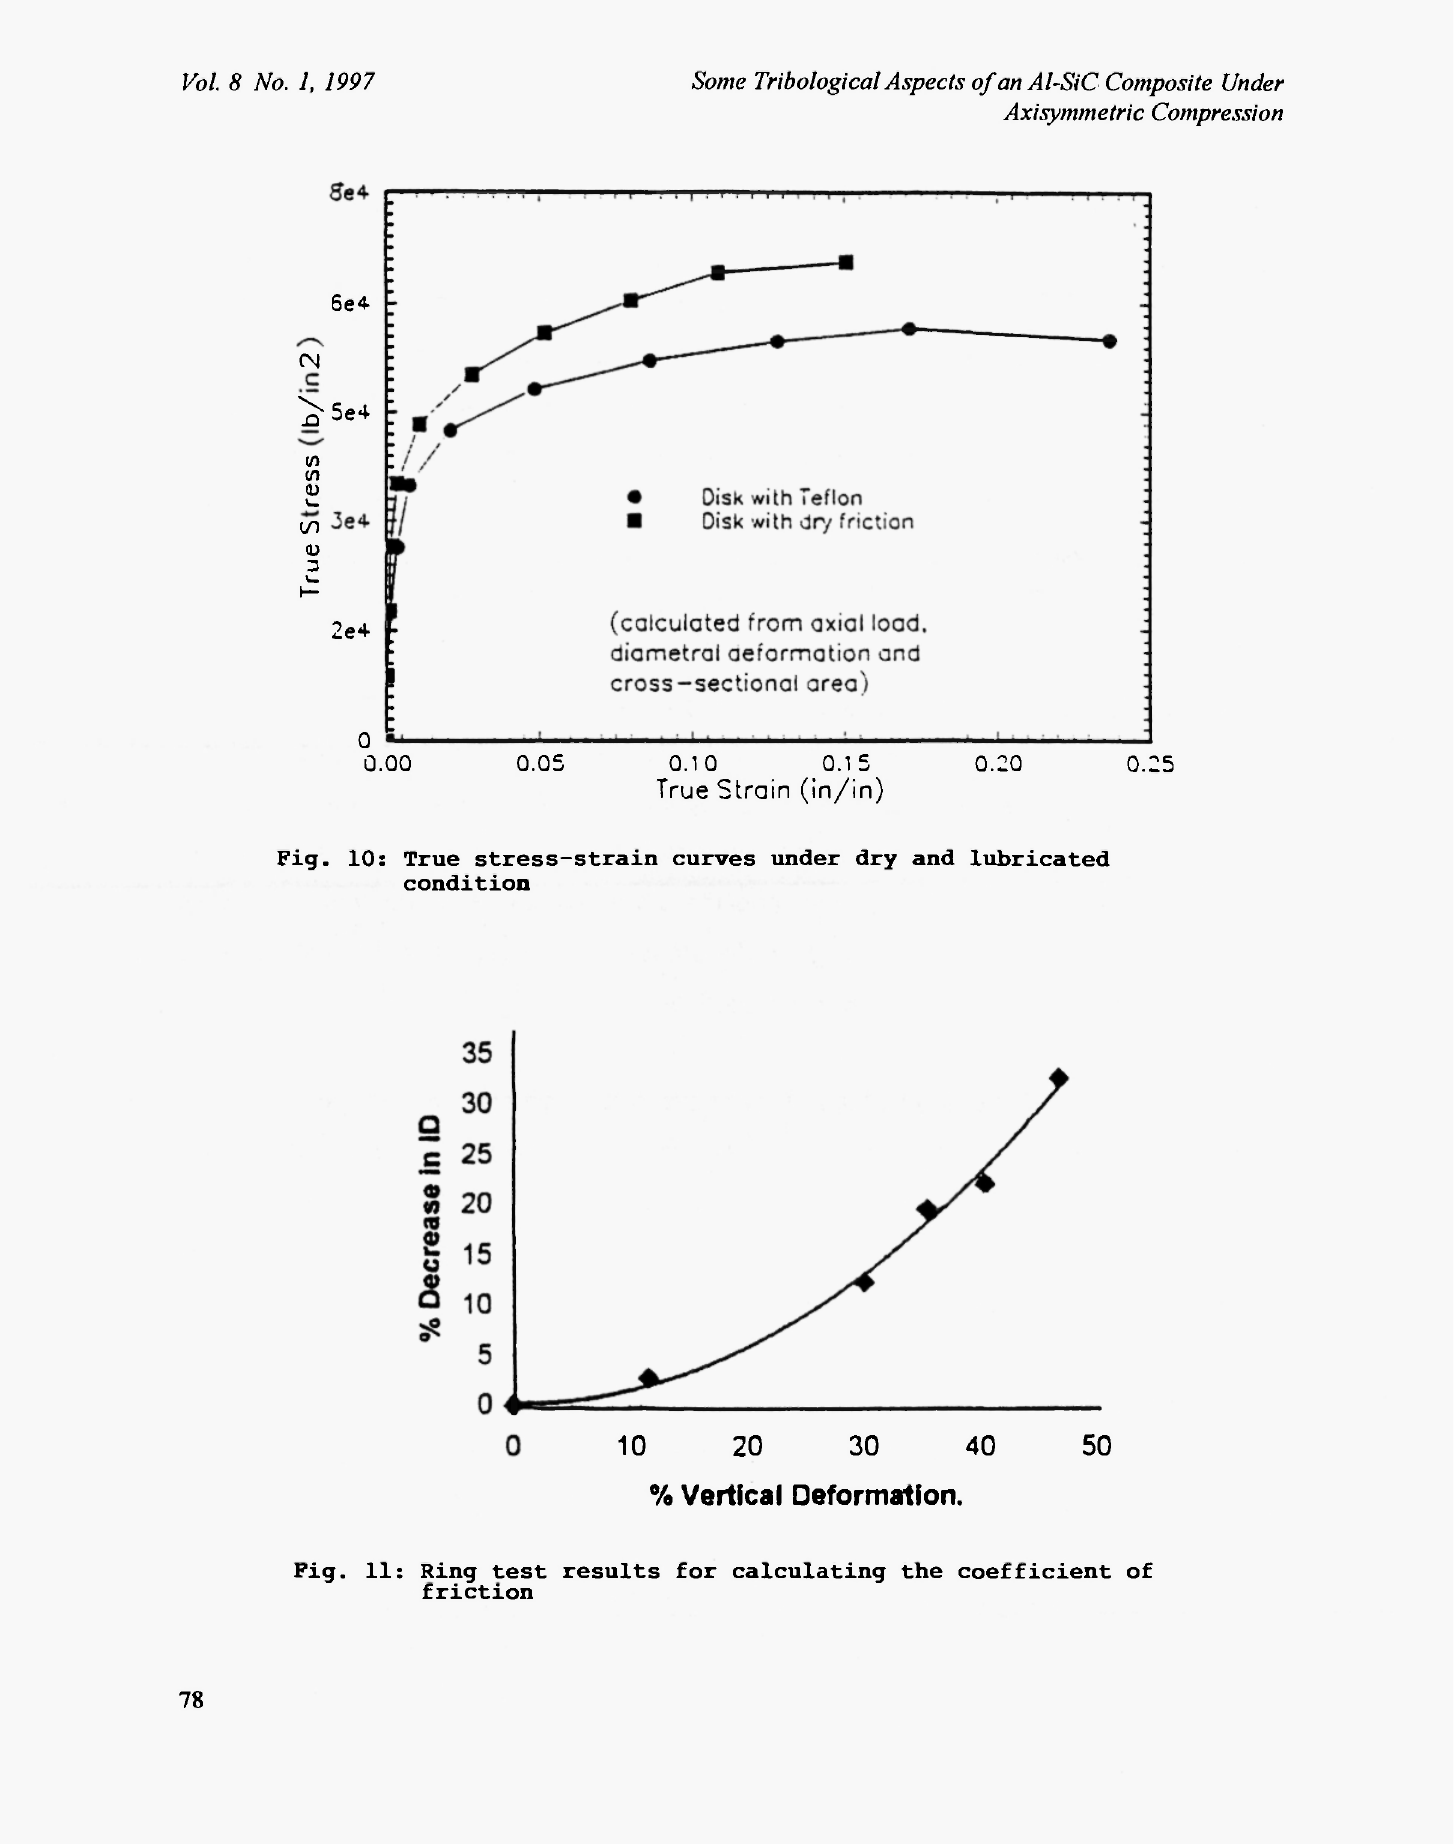
Fig. 10: True stress-strain curves under dry and lubricated condition